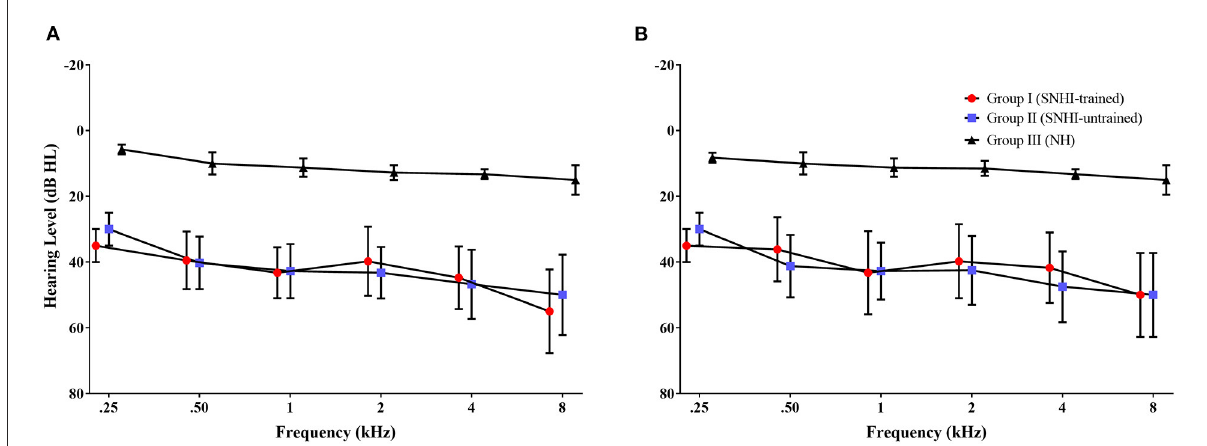
FIGURE1 The mean hearing thresholds of participants in each group across audiometric frequency range for (A) right ear and (B) left ear. The error bar represents ± 1 SD.